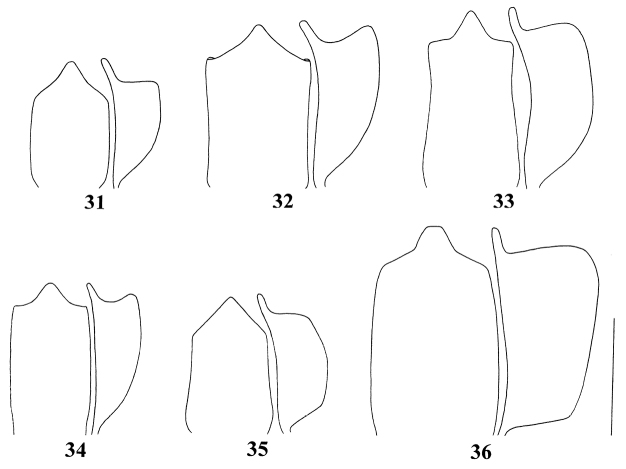
Penis in ventral and lateral view of Pseudocneorhinus species 31Pseudocneorhinusangustus sp. nov. 32P.glaber sp. nov. 33P.setosicallus sp. nov. 34P.adamsi35P.bifasciatus36P.subcallosus. Scale bar: 0.50 mm.